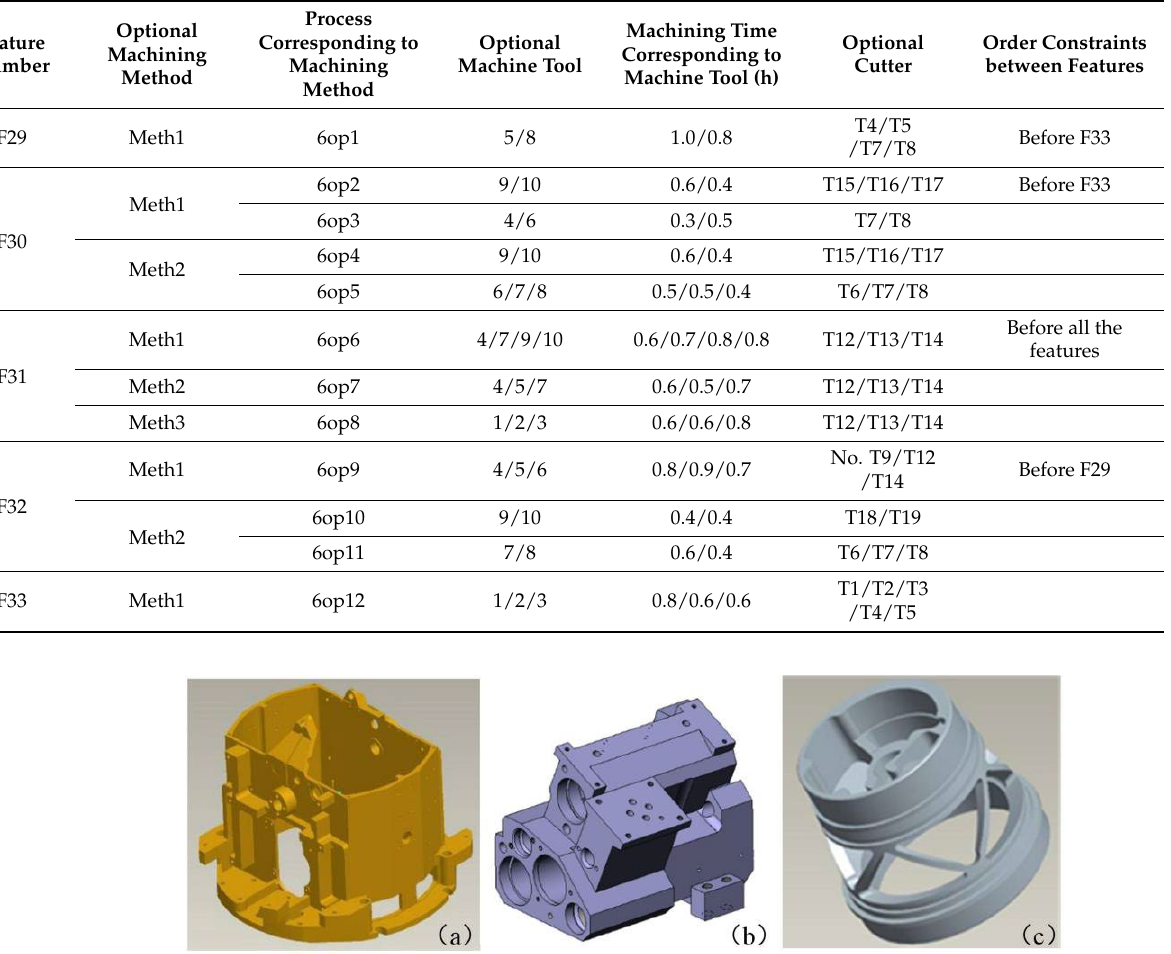
Figure 12. Sample parts. ( a ) Shell; ( b ) Passage Body; ( c ) Fuze Seat. Table 5. Processing equipment information and cost per unit Table 4 . Parts’ Processing Technology Information.